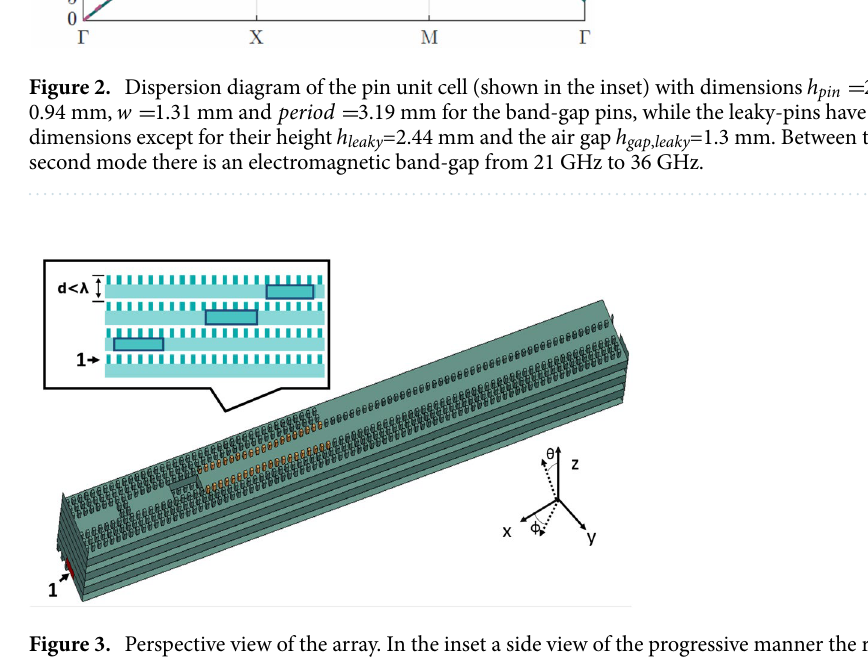
from 8.1 mm and ending with 7 mm) in order to control the attenuation constant making it smaller at the begin- ning of the antenna and progressively bigger at the end as in 15 , the directivity varies between 19.3 and 19.6 dBi from 27.4 to 28.6 GHz. If now two antennas are simply stacked and fed with the same amplitude and phase, the directivity can increase up to 22–22.2 dBi for the same frequencies. If a total of four antennas are stacked, the directivity reaches 25.8 dBi. These directivity levels, correspond to a spacing of 7.9 mm (0.7 (cid:31) 0 at 28 GHz) between the antennas. This spacing is the result of a parametric study of the distance between the elements, that was changed by changing the thickness of the upper wall of the waveguides. More radiating elements of this type could be stacked to form an array with higher levels of directivity. For the purposes of this paper, a four element array was chosen to demonstrate the proposed methodology. The inter-element distance is defined by the thickness of the upper broad wall of the waveguides, that separates the antennas, plus the height of the the waveguide itself (see the inset of Fig. 3). To avoid the appearance of grat- ing lobes, the spacing between the elements should be less than (cid:31) 0 at the operating frequencies. Since the air gap and the pin height are fixed to achieve the desired band-gap following the example of the antenna designed in 15 , the inter-element distance is controlled only by the thickness of the broad walls. Later in this paper, the distance between the antennas is taken under consideration when designing the vertical coupler. Vertical coupler and phase correction. In order to study the number of elements to be stacked, the array was fed by n waveguide ports, directly connected to each element to obtain uniform feeding (same amplitude and phase). However, this is not a realistic scenario. In this direction we have designed a vertical feeding network that requires direct feeding by a standard WR34 waveguide transition only in one element of the array. The aim of the proposed feeding network is to couple the energy uniformly to all the antennas to maximize the directivity. As indicated in Fig.3 the feeding is done at the first (bottom) antenna by a waveguide standard